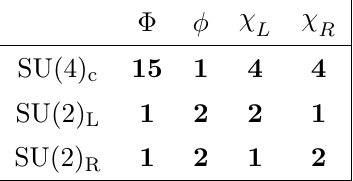
Table 1 . The scalar content which we utilise and their respective dimensions under each PS gauge